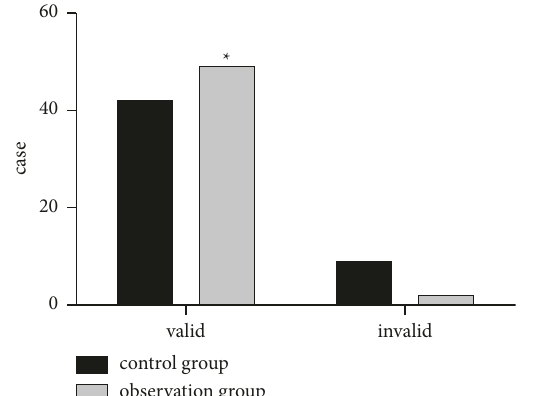
Figure 1: Clinical efficacy of the two groups of patients. Compared with the control group, ∗ P > 0 .